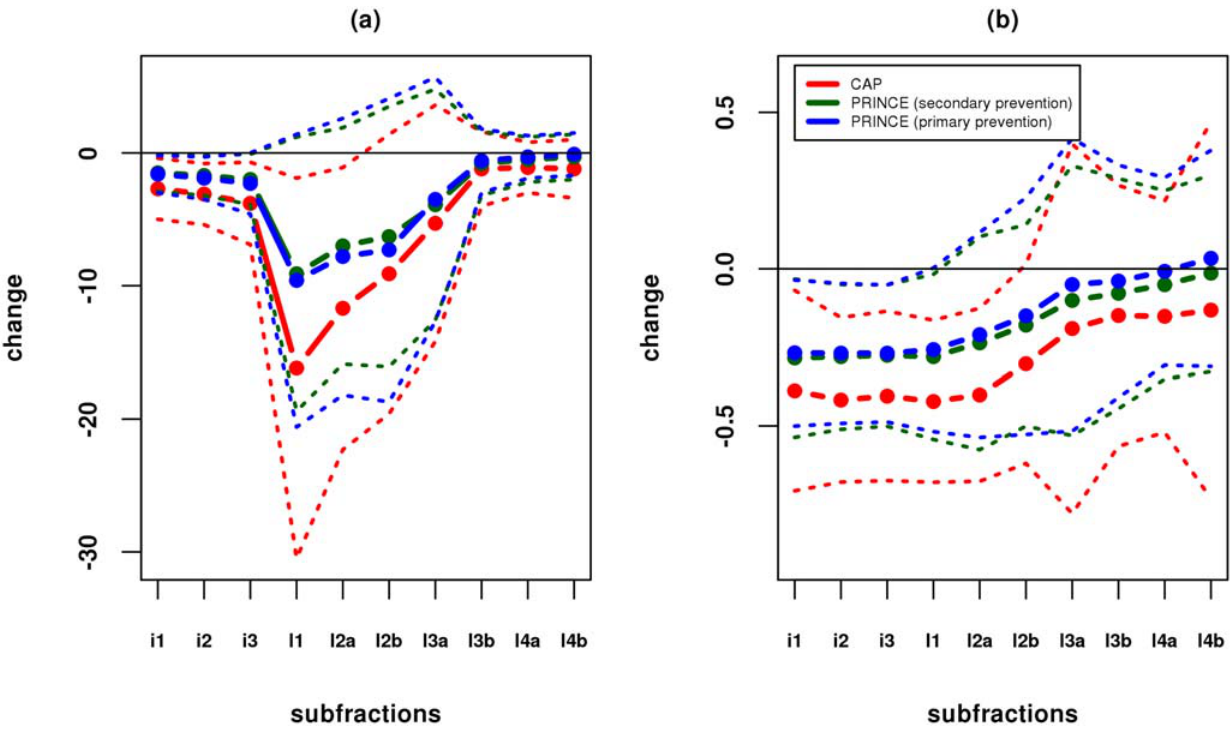
Fig 1. Effects of statin on cholesterol concentrations in LDL subfractions. Dashed lines show (a) mean absolute change, and (b) mean fractional change, in each study/cohort in each subfraction (see Table 1 for abbrevations); dotted lines show ± one standard deviation; subfractions are in order from lower (left) to higher (right) density